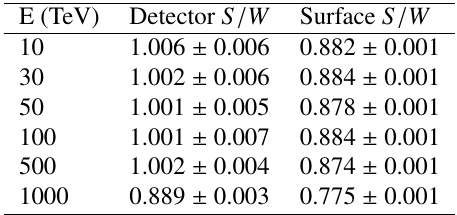
Table 1: Ratios of the summer and winter muon flux for showers at θ = 30 ◦ and di ff erent energies, measured at the detector and the surface planes, respectively.